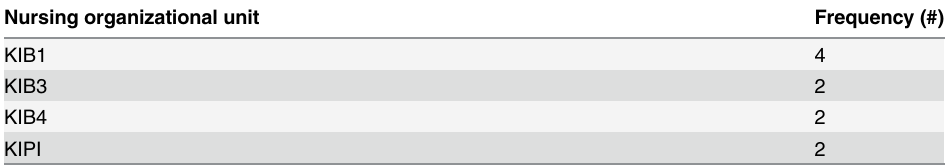
Table 5. Total frequencies of the most common nursing terms (nursing organizational unit) which occur in cyclic treatment